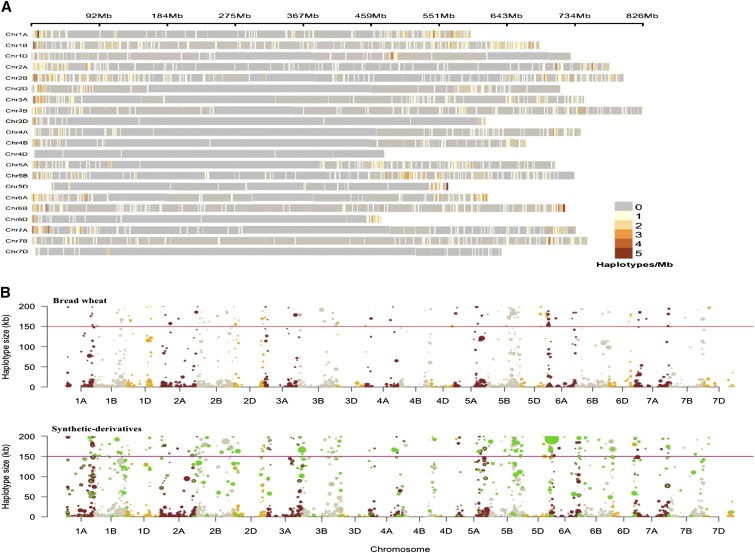
a) Haplotypes density along each of the wheat chromosomes. b) Distribution of haplotypes along wheat genome, where y-axis represent size of the haplotype block (kb) and size of the bubble represent number of SNPs/block. Green haplotype blocks are specific to the SYN-DER panel.